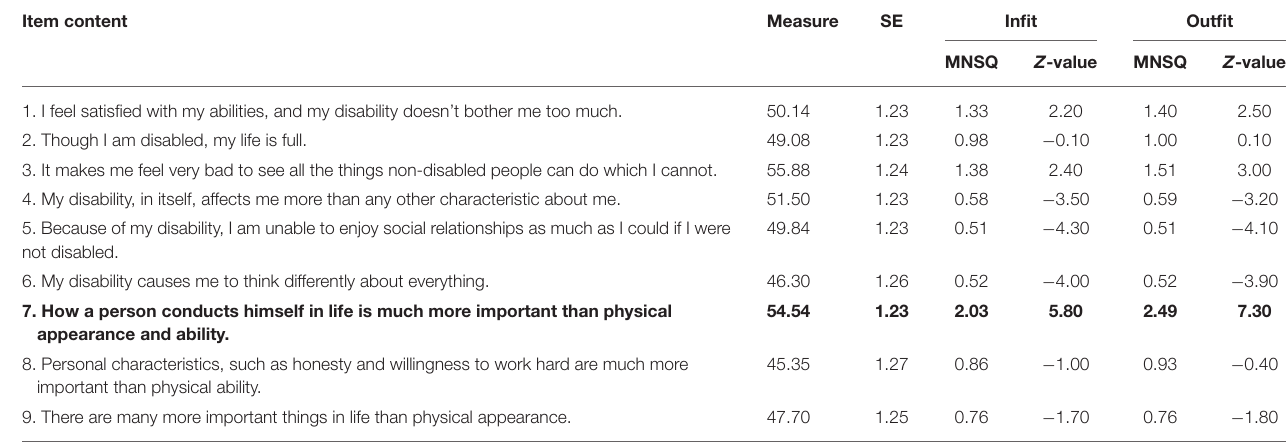
TABLE 2 | Item fit statistics according to entry order for nine items. Item content